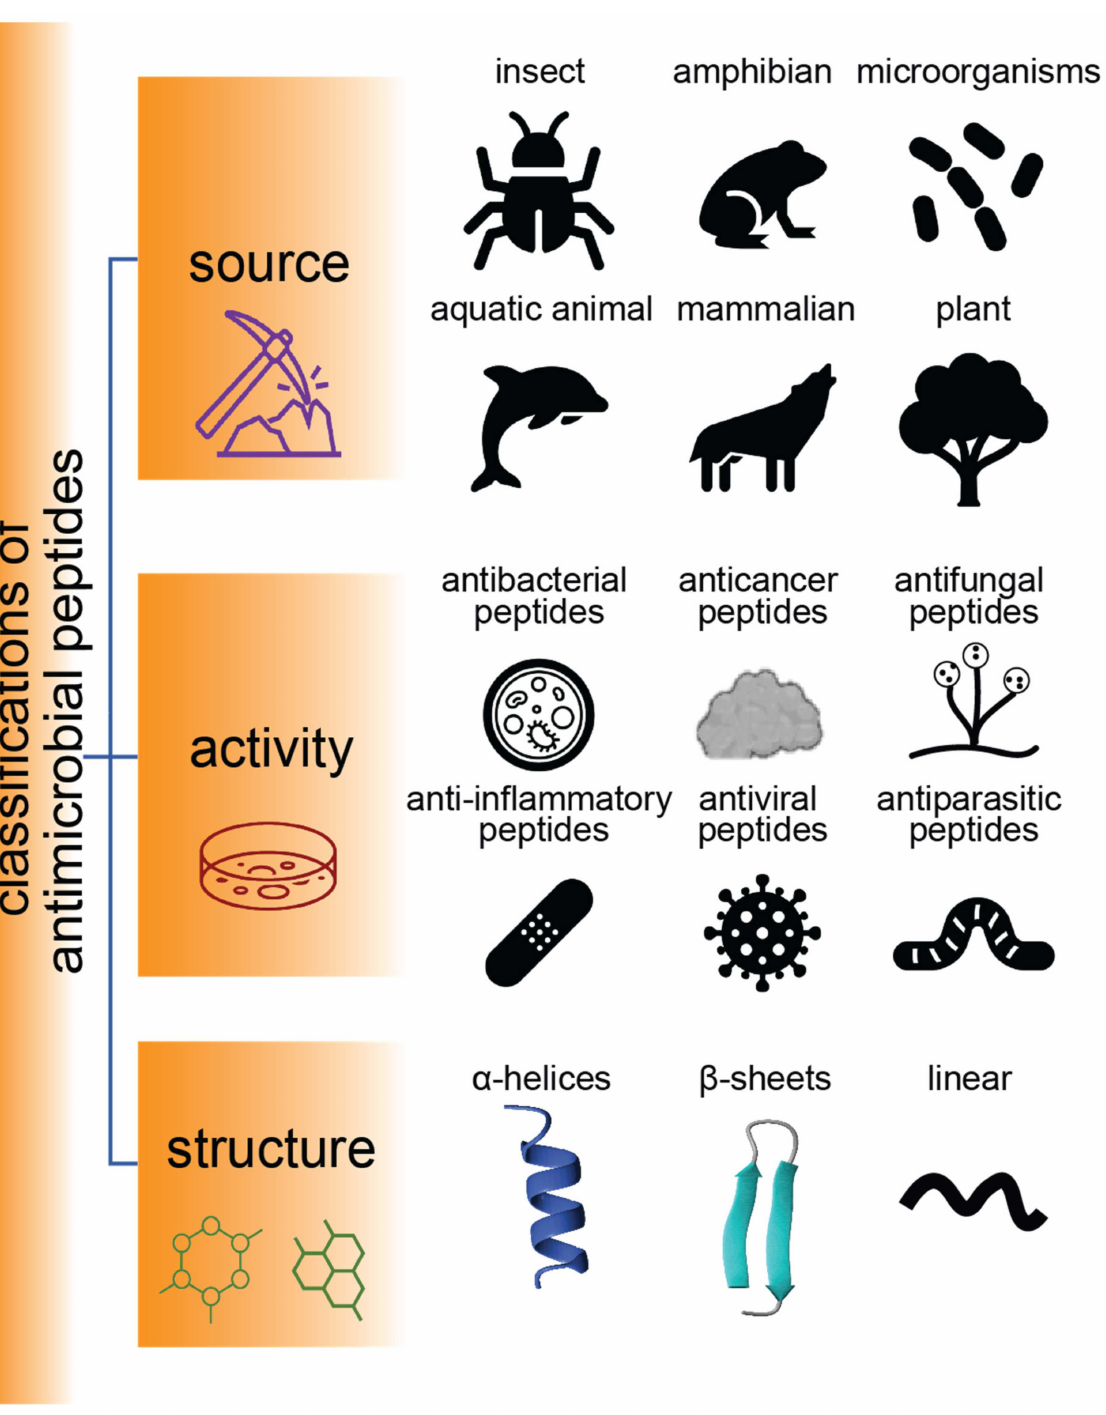
Figure 1. Classification of AMPs. Schematic representation of sources, activities, and structures of